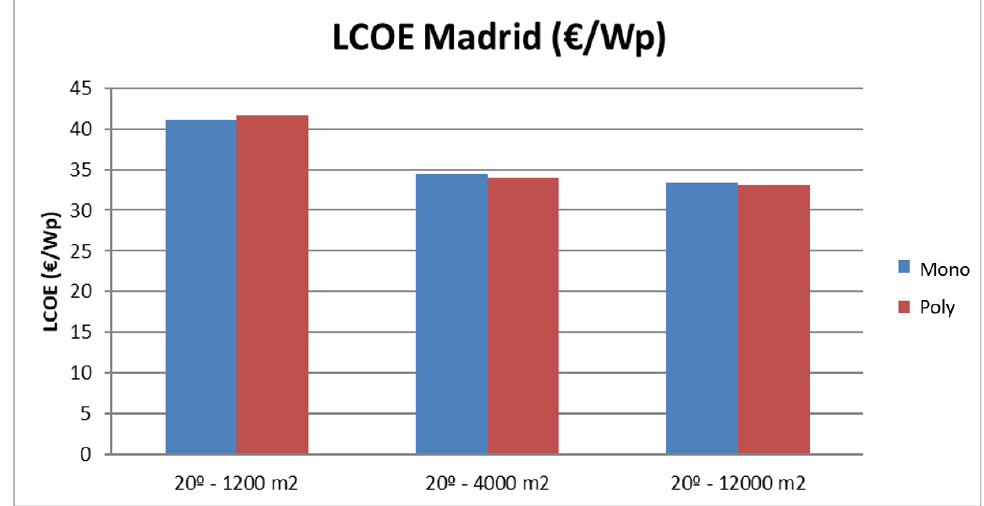
Figure 14. LCOE in Madrid for installations with an inclination of 20°.